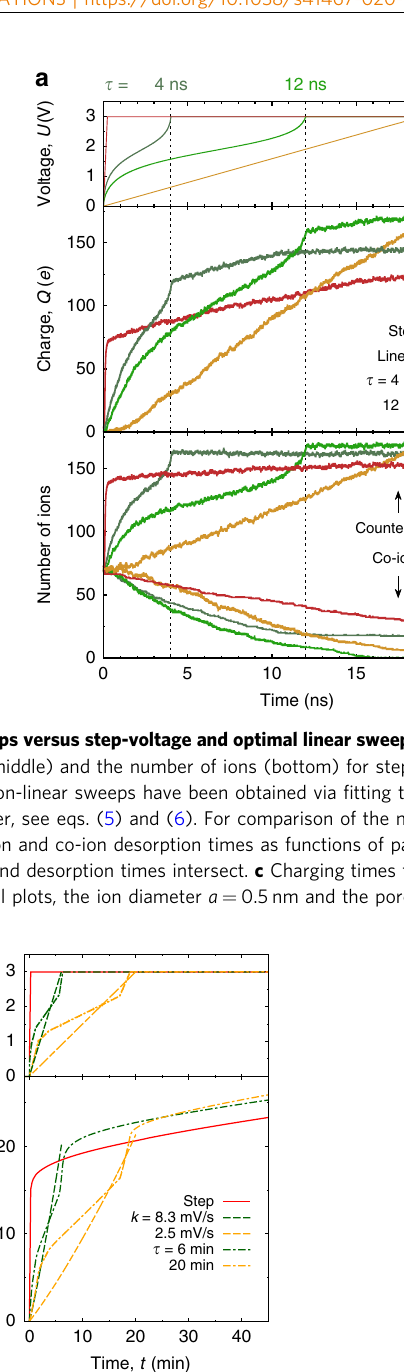
Fig. 4 Non-linear sweeps versus step-voltage and linear sweeps for novolac-derived carbons. Cell voltage (top) and accumulated charge (bottom) for step-voltage, linear, and non-linear sweep charging. For the non-linear sweeps, cell voltage vs time have been obtained by using the stretched exponential approximation (see eq. (3)), for two values of τ , as indicated on the plot. The linear sweeps have been obtained via a one-cycle voltammetry; the discharging parts of these curves are not shown for